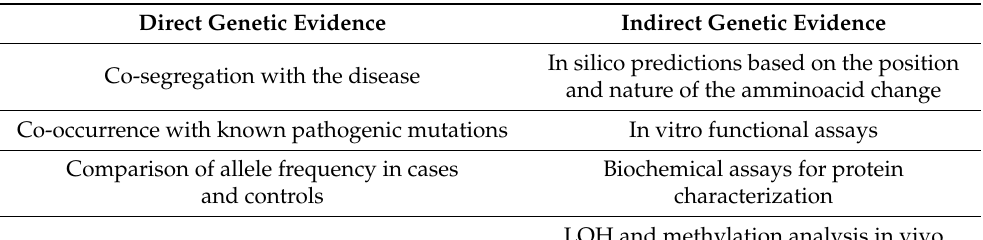
Table 3. Strategies used to clarify the clinical role of